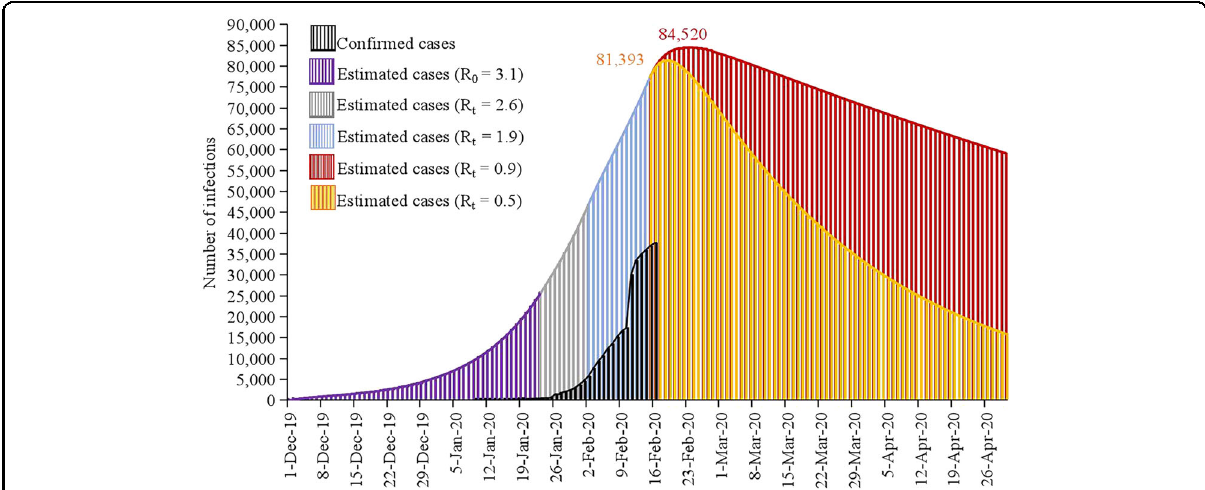
Fig. 3 Phase-adjusted estimation of the number of COVID-19 cases in Wuhan, China (1 December 2019 – 30 April 2020, E = 30I). In all, 81,393 represents the estimated peak number of COVID-19 cases on 19 February 2020 in Wuhan, China with R 0 = 0.5; 84,520 represents the estimated peak number of COVID-19 cases on 23 February 2020 in Wuhan, China with R 0 = 0.9; E : number of exposed cases; I : number of infectious cases; E was assumed to be 30 times of I at baseline.